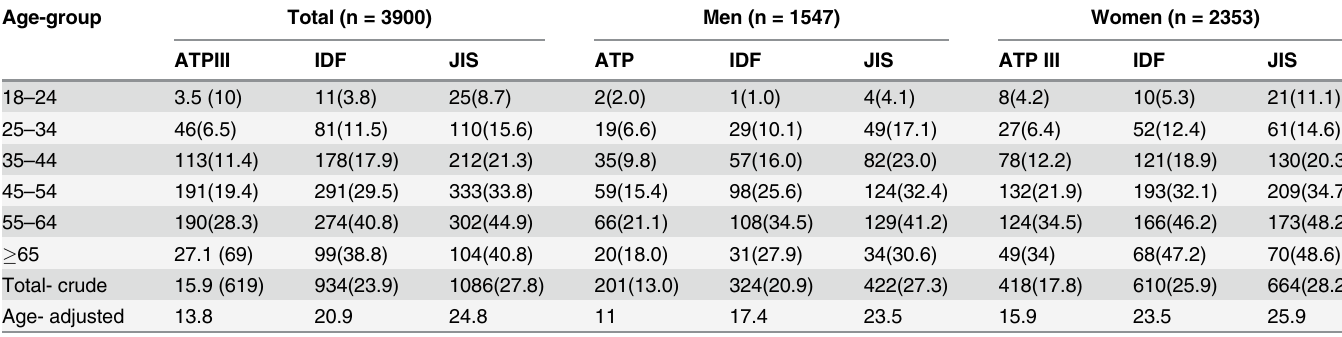
men (sensitivity:61.1%, specificity:62.1%) corresponded to the shortest ROC curve distance (0.54), and 83 cm in women (sensitivity:60.0%, specificity:59.6%) corresponded to the shortest ROC curve distance (0.57). The evaluation consequences of other cut-off values are shown in Table 5.